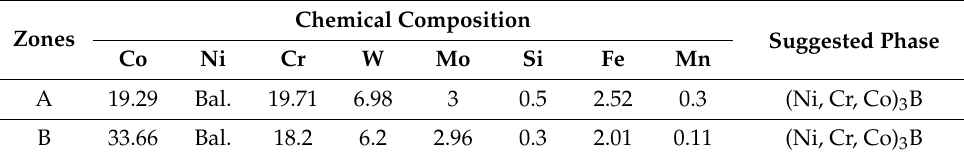
Figure 18. SEM micrographs of the coarse block precipitation zone on the side of the ( a ) FSX-414 and ( b ) X-45 with the 1010 ◦ C/10 min bonding condition. Note: (A) and (B): (Ni, Cr, Co) 3 B. Table 7. EDX analysis of various phases indicated in Figure 18 (wt. %).